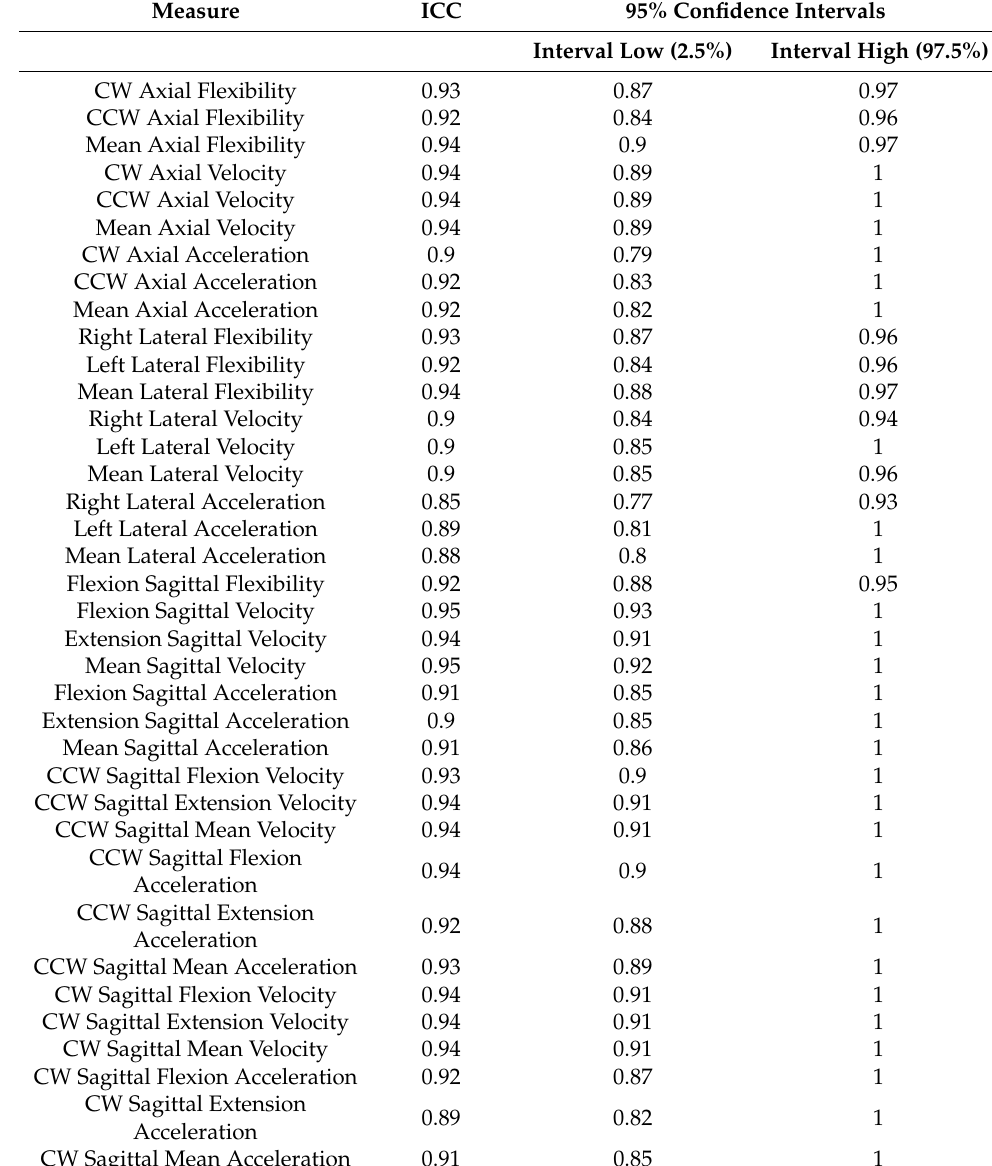
Table 3. ICC values estimated for intra-rater reliability of all